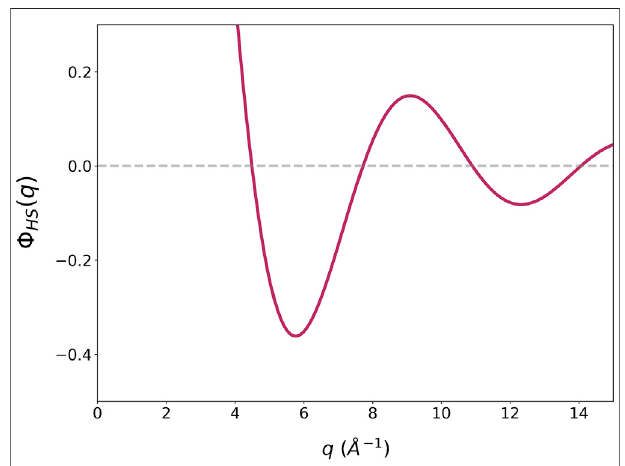
FIGURE 7 | The Fourier transform of the pseudopotential of the hard- sphere potential, ϕ HS ( q ), with the cut-off at 1 energy unit and D HS = 1